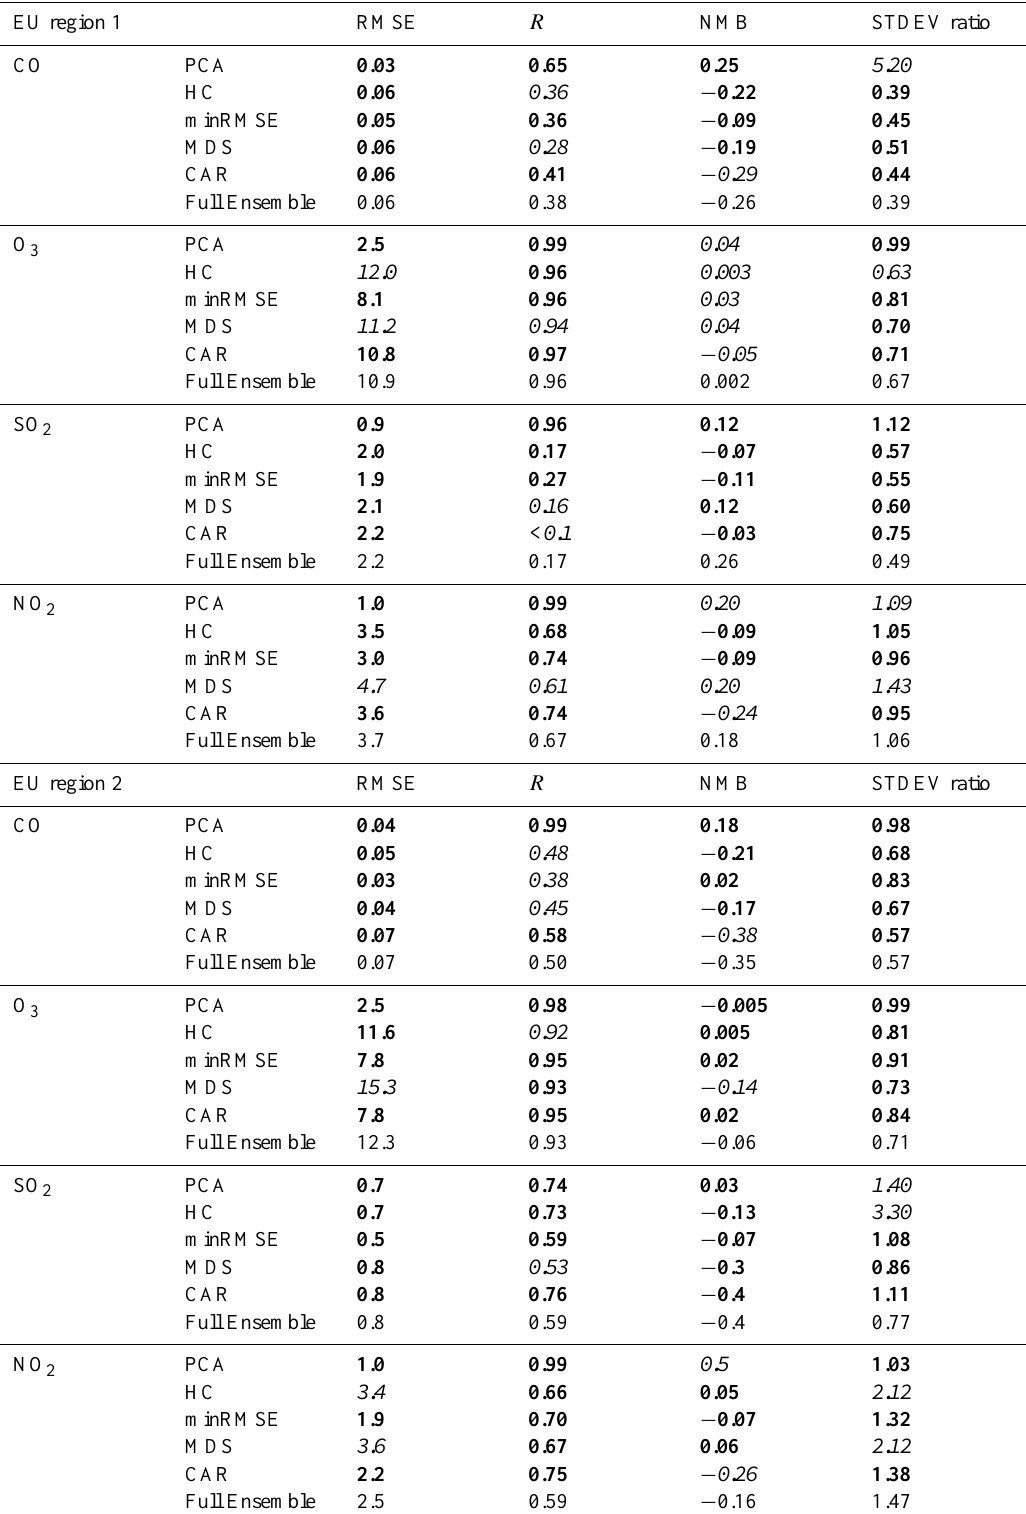
Table 5. Ensemble skills for regions 1 and 2 of Europe (JJA). (RMSE: root-mean-square error; R : Pearson correlation coefficient; NMB: normalised mean bias; STDEV ratio: modelled to observed standard deviation). Results in bold are those for which the selected ensemble scores better or as well as the full member ensemble (vice versa for the values in